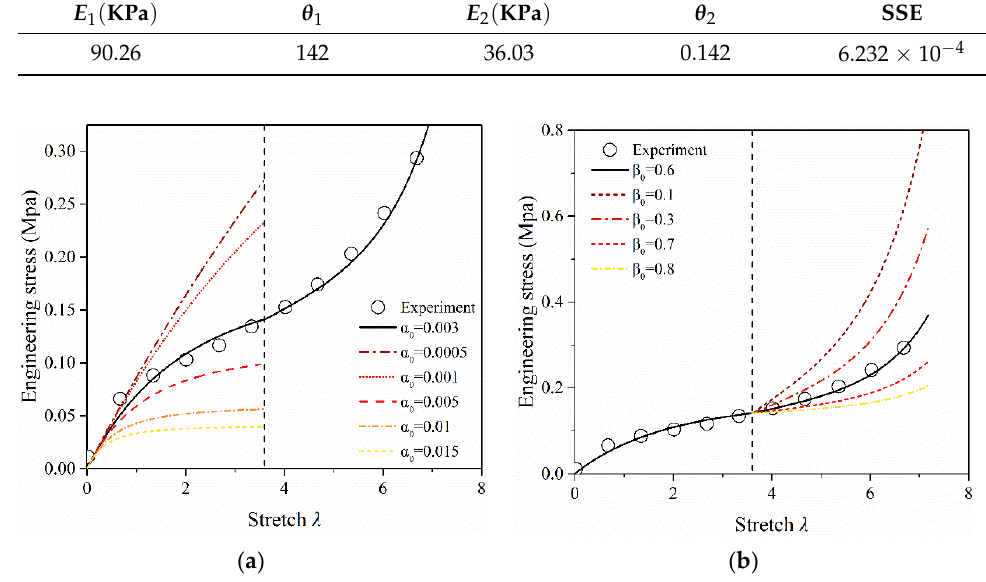
Figure 5. The sensitivity of stress response to order parameters; ( a ) α 0 , ( b ) β 0 . (The experimental data was taken from the uniaxial tensile tests of VHB 4910 at a rate of 0.065/s, as reported in